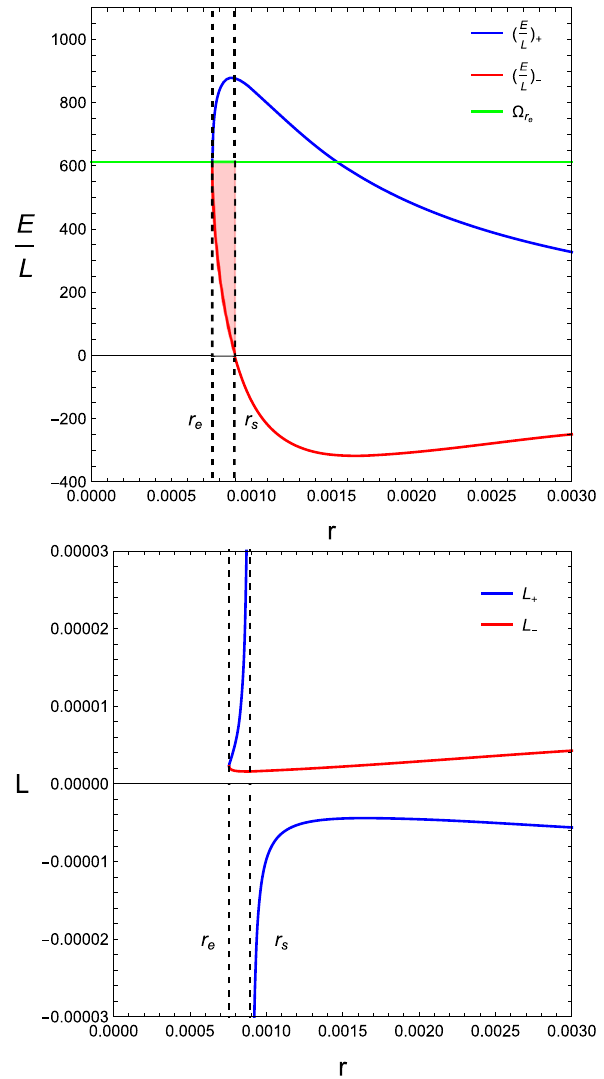
Fig. 3 E and L as the function of r for the upper and lower panel, L respectively. The forbidden regions in two plots are presented with the event horizon at r e ≈ 756 µ m, the static limit at r s ≈ 893 µ m, and the = v θ = 612 . parameters ξ = 275 µ m, (cid:2) r r e e